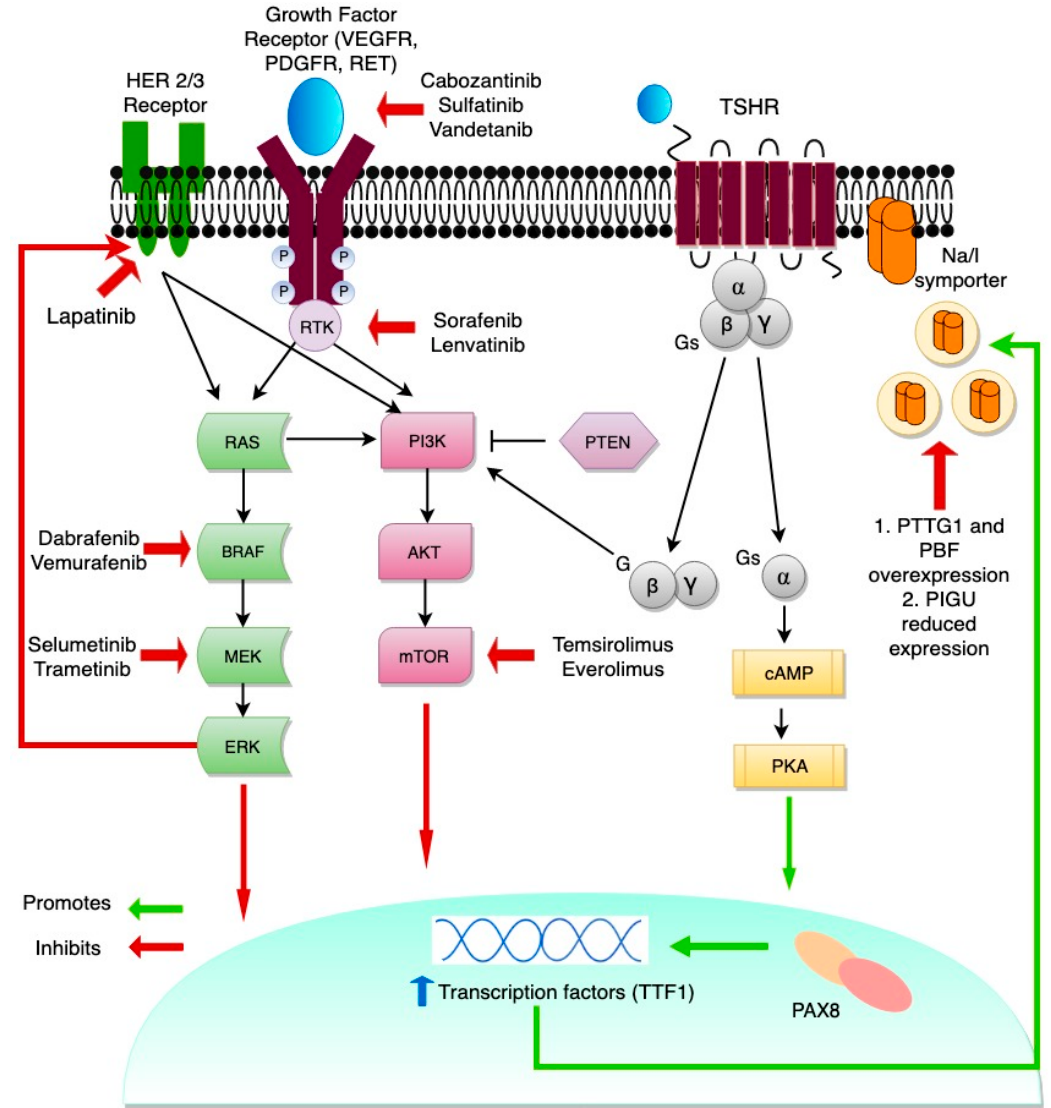
Figure 1. Redifferentiation of thyroid cancer. MAPK ( mitogen-activated protein kinase) (RAS/RAF/MEK) and PI3K/AKT/mTOR are key signaling pathways in thyroid cancer pathogenesis. Signaling cascades can be blocked by new targeted therapies. The crosstalk between MAPK and PI3K through RAS is shown and represents a tumor escape mechanism from known multi-kinase inhibitors and selective inhibitors of BRAF. PI3K-AKT pathway activation leads to suppression of NIS (sodium/iodide symporter) glycosylation and surface translocation. The inhibition of mTOR promotes redifferentiation of thyroid cancer cells by upregulation of NIS mRNA and protein expression through increased transcription of TTF1. Another important positive regulator of NIS expression is PTEN. TSH (thyroid stimulating hormone) signals through the heterotrimeric G-protein complex, and through activation of cAMP increases transcription of the NIS gene. Aberrant activation of the MAPK signaling pathway inhibits PIGU expression and NIS basolateral transport. PTTG1 and PBF overexpression results in decreased NIS levels in thyroid cancer.